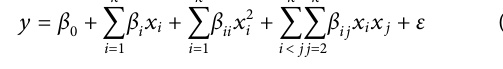
Frontiers in Physics |